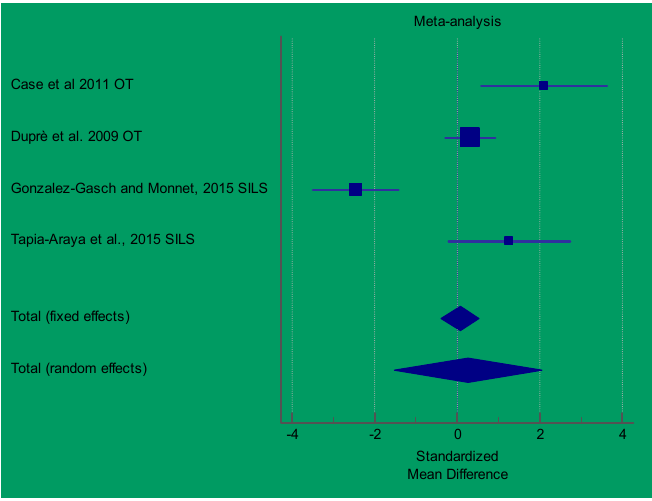
Figure 3. Forest-plot chart of the articles analyzed in terms of the surgical time of Ovariectomy (OVE) procedures. OT: operative telescope; SILS: SILS port platform. (Q 38.2976; I 2 92.17%; p < 0.0001).